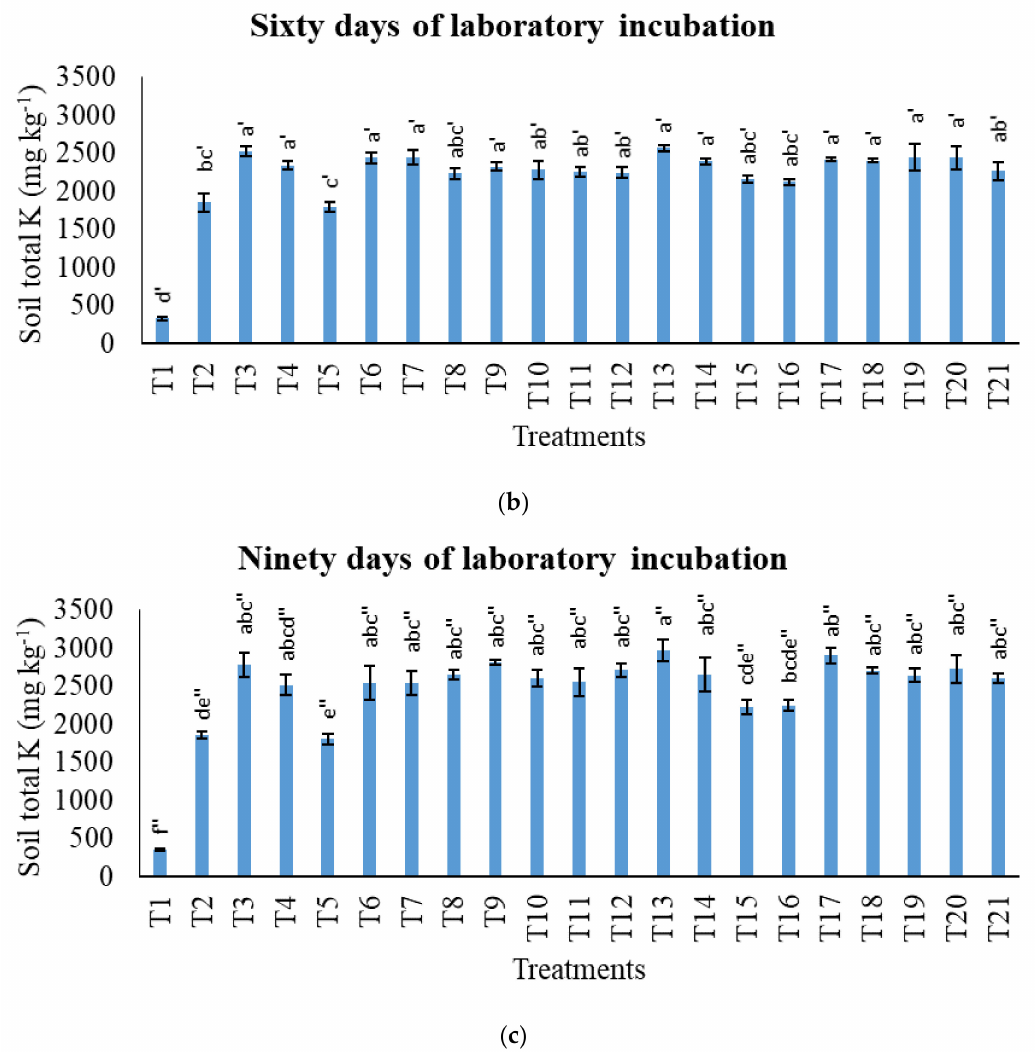
Figure 11. Effects of treatments on soil total potassium over ( a ) thirty; ( b ) sixty; and ( c ) ninety days after incubation.T1: soil control, T2: conventional practice, T3: muriate of potash + 100% charcoal + 100% sago bark ash, T4: muriate of potash + 100% sago bark ash, T5: muriate of potash + 100% charcoal, T6: muriate of potash + 80% charcoal + 80% sago bark ash, T7: muriate of potash + 60% charcoal + 80% sago bark ash, T8: muriate of potash + 40% + 80% sago bark ash, T9: muriate of potash + 20% charcoal + 80% sago bark ash, T10: muriate of potash + 80 charcoal + 60% sago bark ash, T11: muriate of potash + 60% charcoal + 60% sago bark ash, T12: muriate of potash + 40% charcoal + 60% sago bark ash, T13: muriate of potash + 20% charcoal + 60% sago bark ash, T14: muriate of potash + 80% charcoal + 40% sago bark ash, T15: muriate of potash + 60% charcoal + 40% sago bark ash, T16: muriate of potash + 40% charcoal + 40% sago bark ash, T17: muriate of potash + 20% charcoal + 40% sago bark ash, T18: muriate of potash + 80% charcoal + 20% sago bark ash, T19: muriate of potash + 60% charcoal + 20% sago bark ash, T20: muriate of potash + 40% charcoal + 20% sago bark ash, and T21: muriate of potash + 20% charcoal + 20% sago bark ash. Different letters indicate significant differences between means using Tukey’s HSD test at p ≤ 0.05. The error bars are the ± standard error of triplicates. Letters without any marks and letters with ‘ and ” indicate mean comparison within thirty, sixty, and ninety days after incubation,